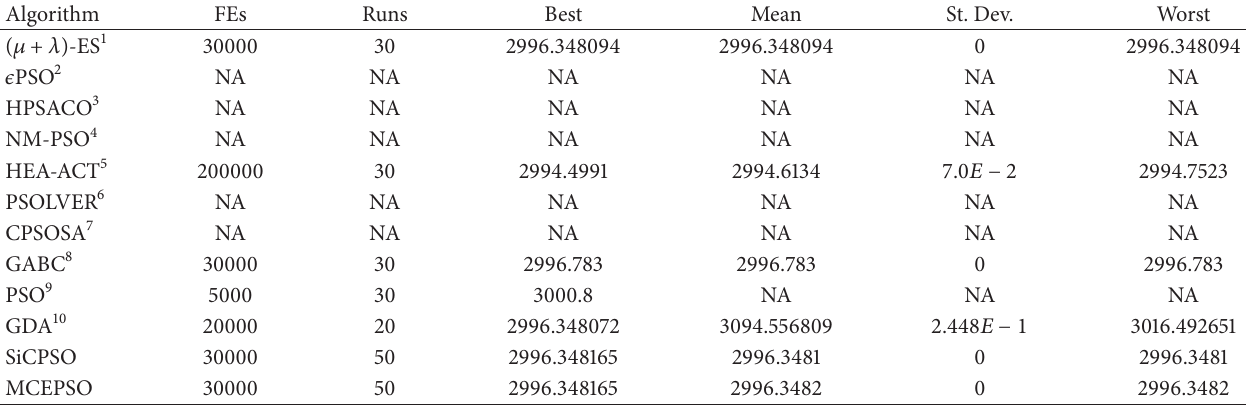
Table 5: Results for E03: speed reducer design.